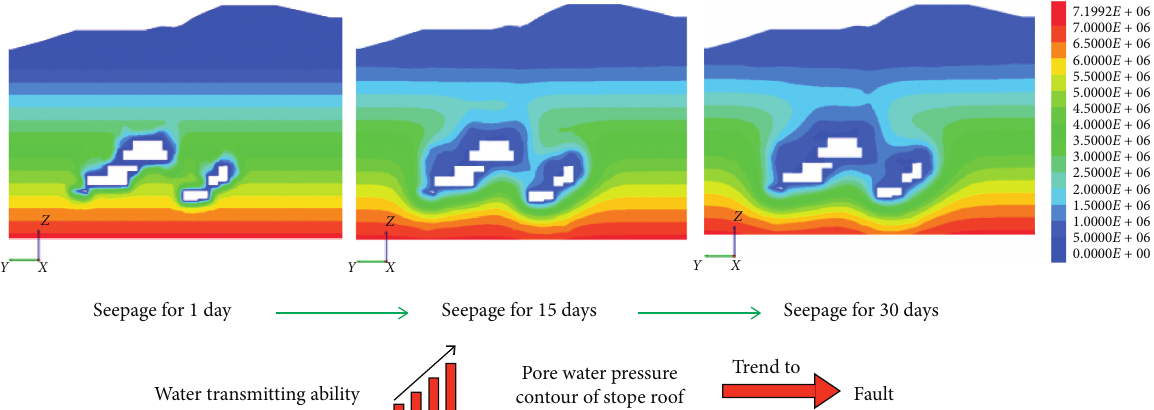
Figure 14: Pore water pressure nephogram (Pa) for different seepage days at section 1 of the